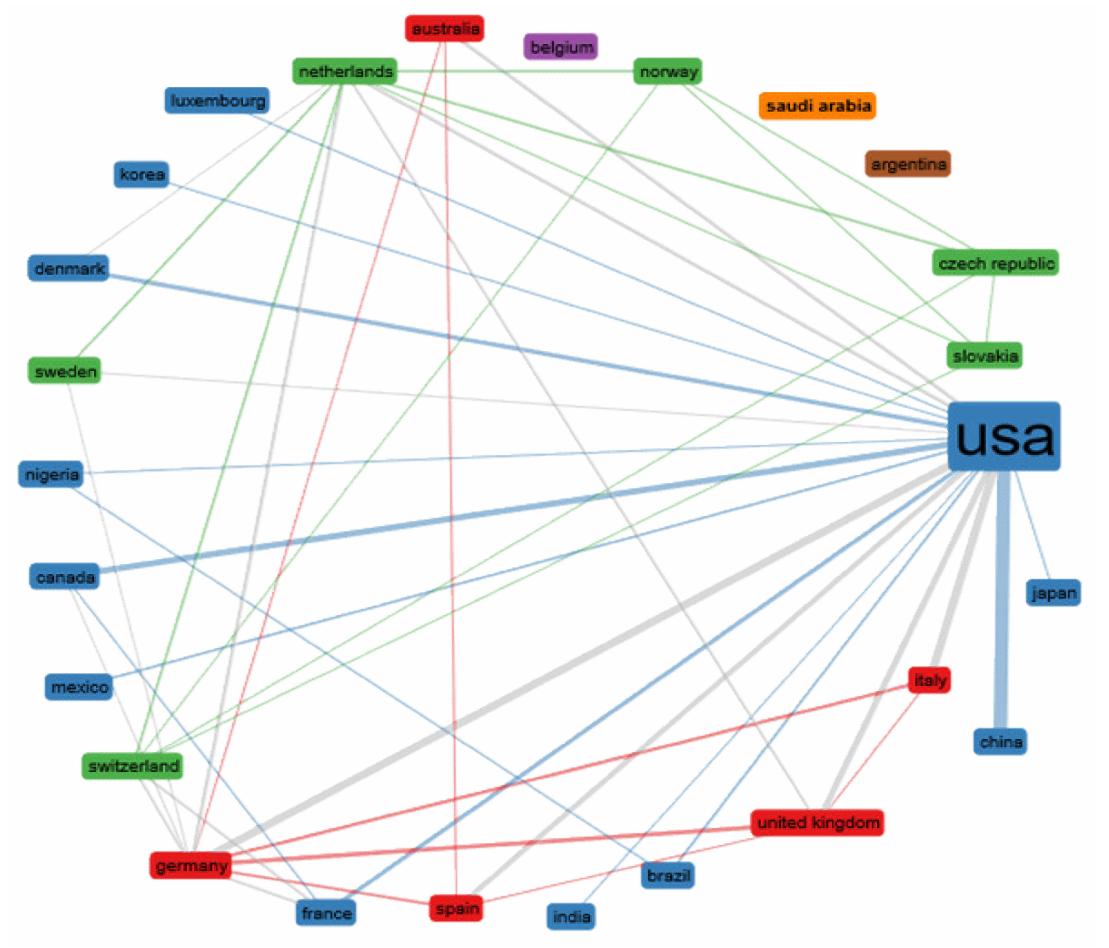
Figure 2. Collaboration among countries from 2011 to